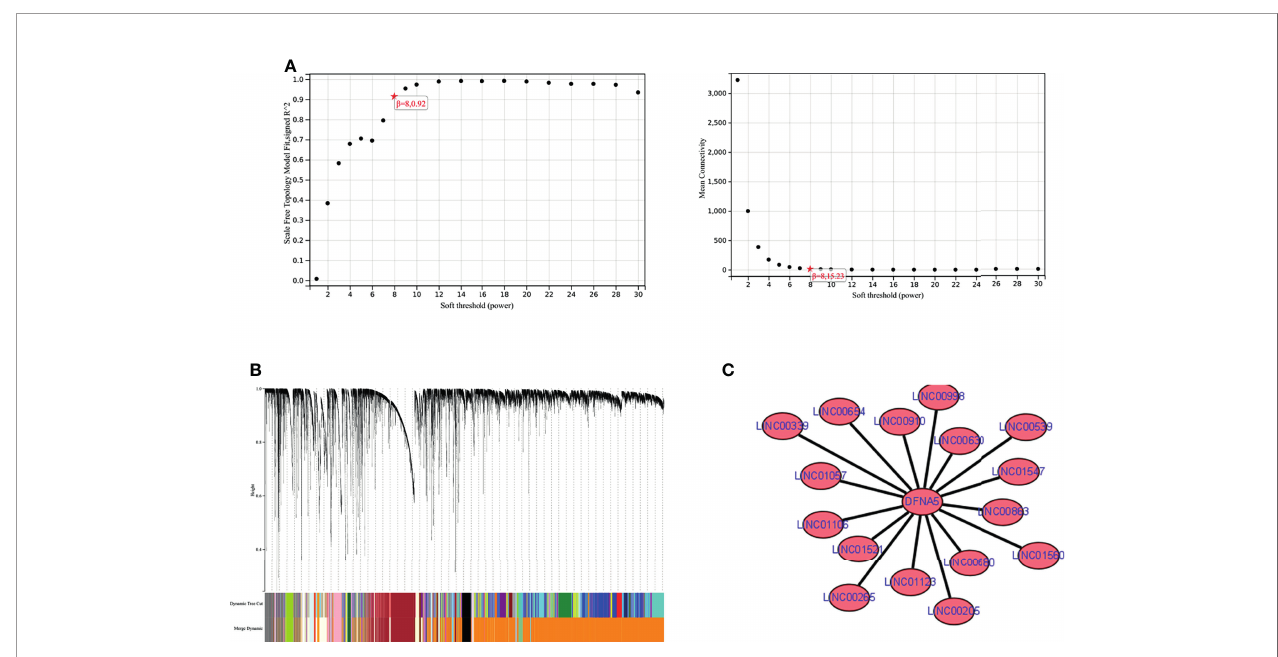
FIGURE 6 | WGCNA analysis. (A) soft threshold determination. (B) gene clustering map. (C) lncRNAs-GSDME interaction network map.